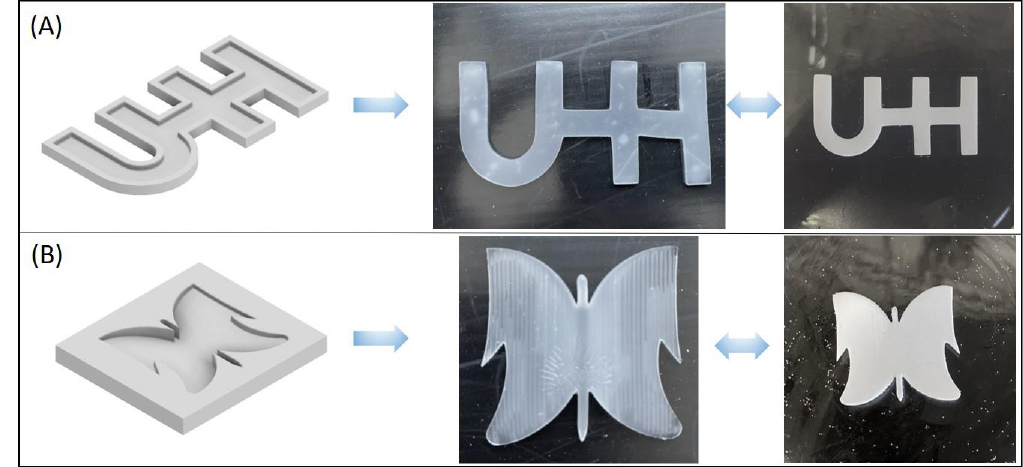
Figure 7. Multiverse shape of the hydrogel. ( A ) logo of UHH; ( B )